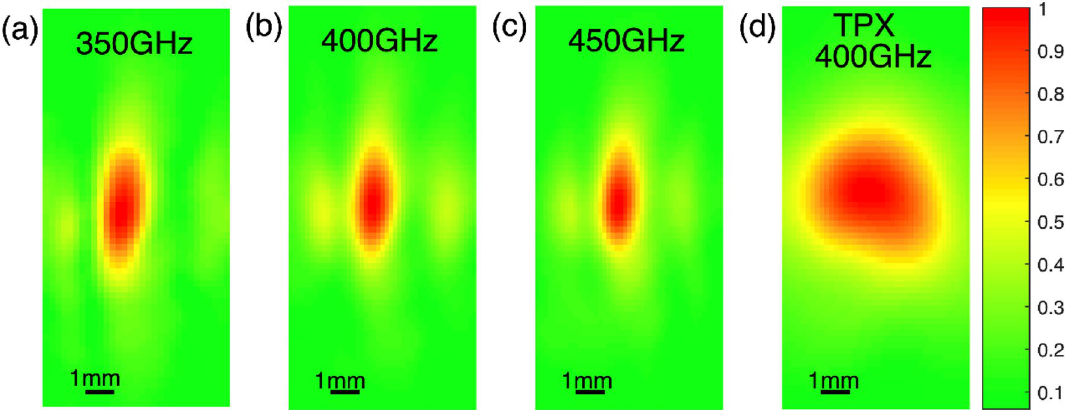
Figure 4. Electric field cross section at the focal point of the metallic axicon at ( a ) 350 GHz, ( b ) 400 GHz and ( c ) 450 GHz. ( d ) cross section of the TPX lens at 400 GHz. The false color images represent the amplitude of the E-field at a particular frequency.